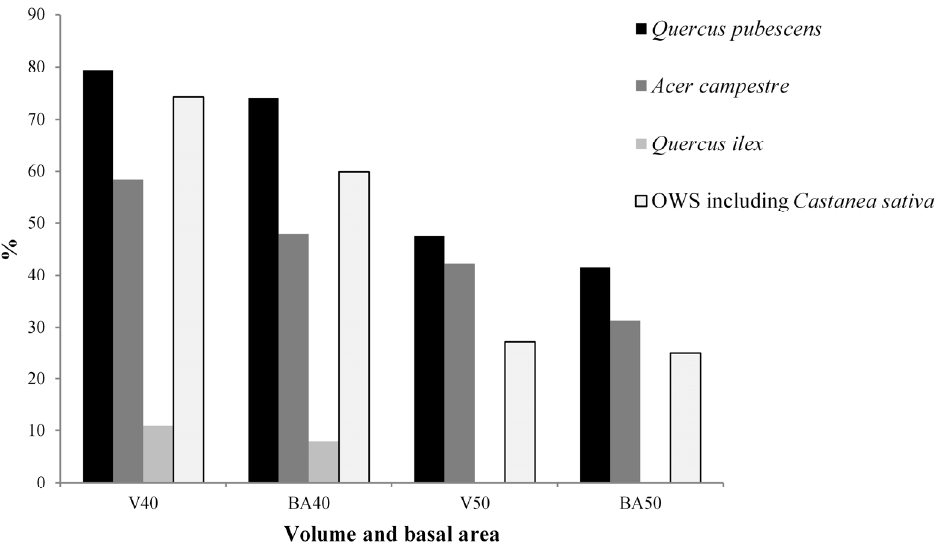
Figure 5. Percentage allocation (%) of volume (V) and basal area (BA) in the largest trees sorted by tree species. The numbers 40 and 50 after V and BA refer to stems with DBH equal to or larger than 40 and 50 cm, respectively.